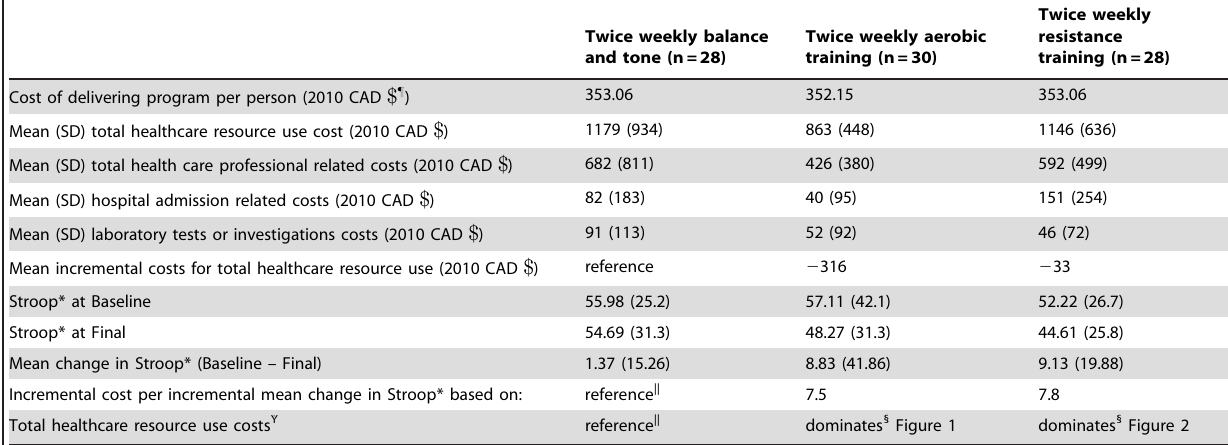
Table 3. Results of base case analysis.